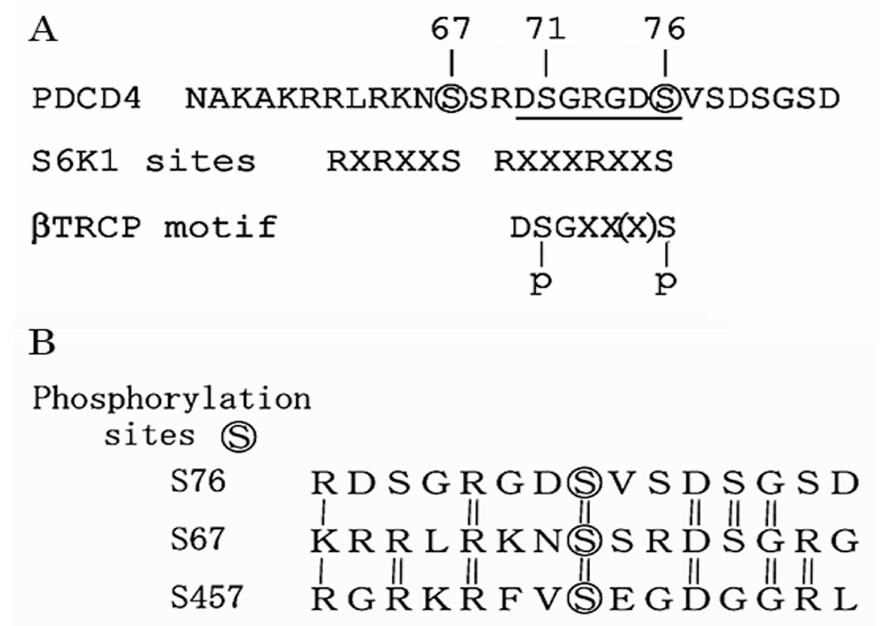
Figure 6. S6K1 phosphorylation sites and β -TRCP binding motif in the PDCD4 protein. ( A ) Serines (S) phosphorylated by S6K1 are marked with circles and SCF β TRCP binding sequence is underlined in the PDCD4 protein sequence. RXRXXS, Canonical S6K1 substrate consensus sequence. ( B ) Homology